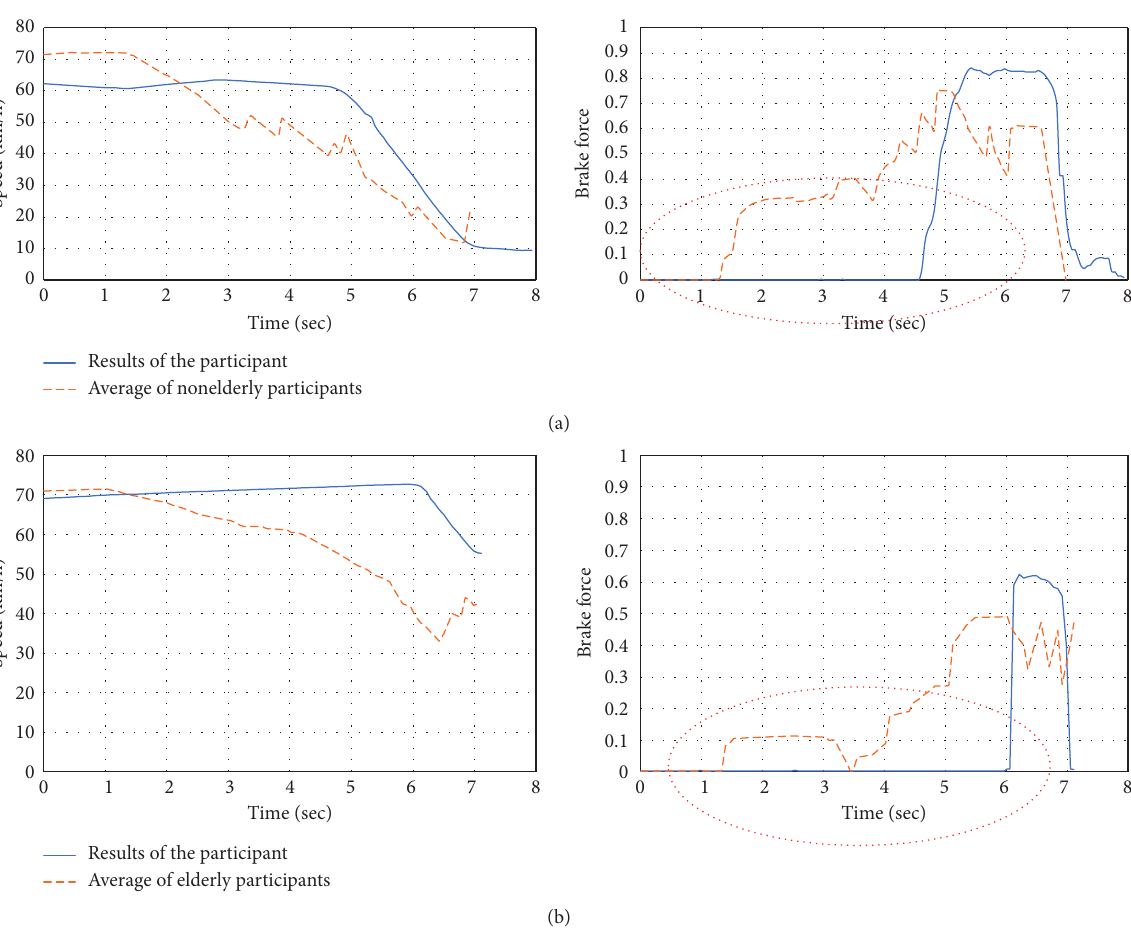
Figure 5: Cases of two problematic participants in the daytime experiment with incident #3. (a) The problematic female participant. (b) The problematic male